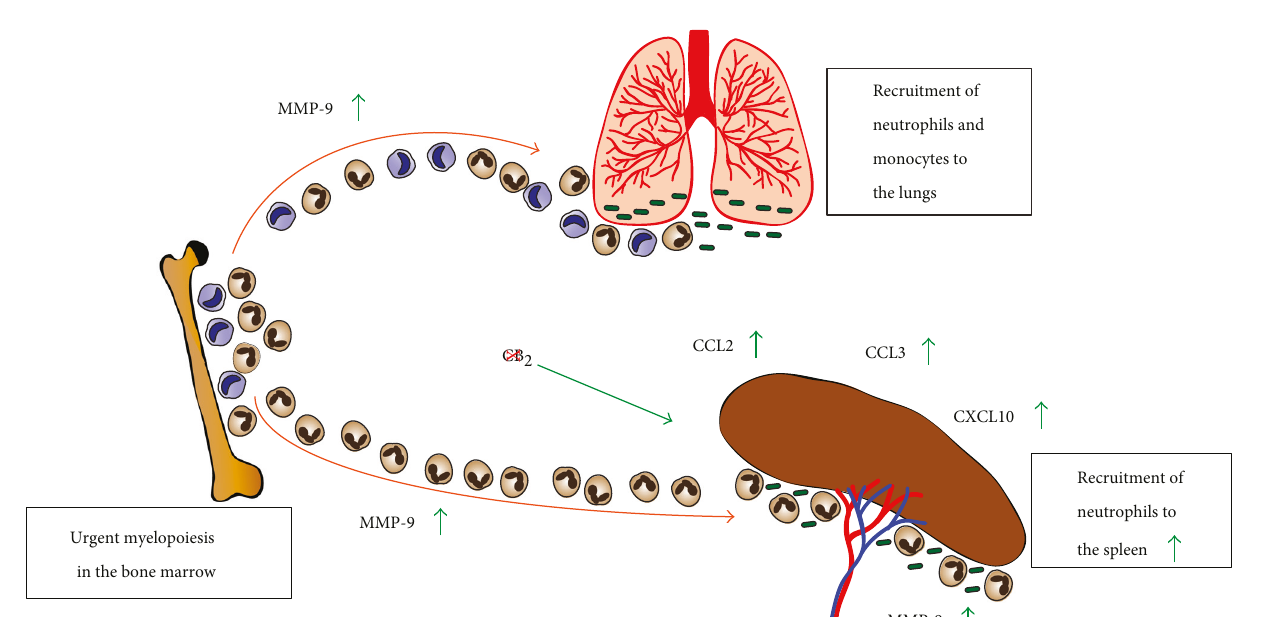
Figure 7: Proposed model for CB function in endotoxemia. During acute systemic in fl ammation CB 2 the spleen. In the absence of this GPCR, the serum levels of the metalloproteinase MMP-9 are elevated and Ccl2 , Ccl3 , Cxcl10 , and Il6 in the spleen are upregulated. As a result CB knockout, neutrophils follow the chemokine gradient and migrate to the spleen in higher numbers 2 than in control littermate